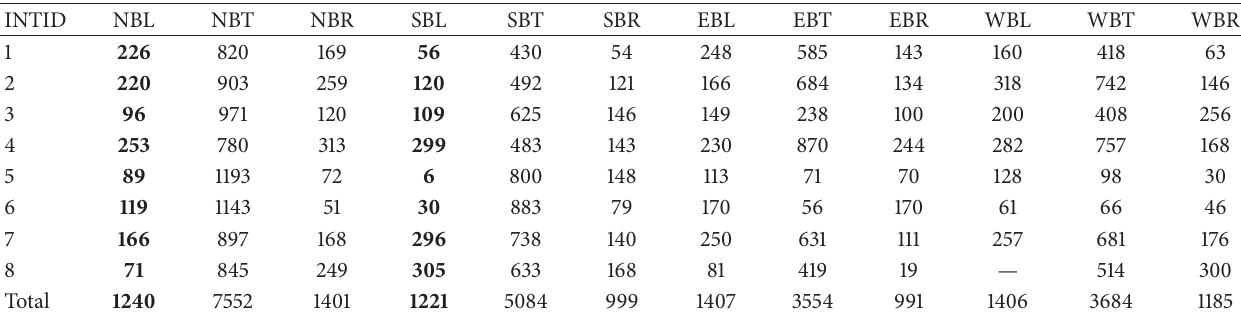
Table 9: Traffic volumes of every intersection in the Kietzke Lane from field data.